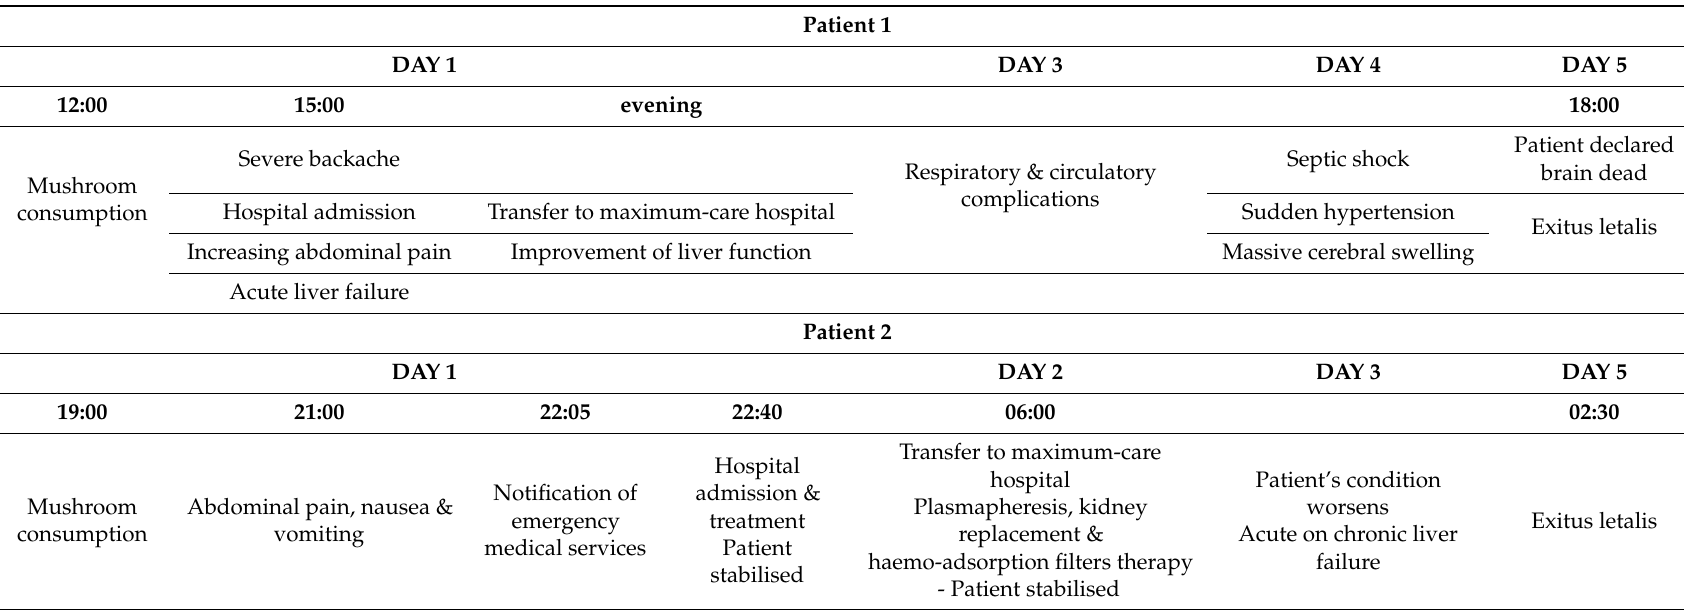
Table 1. Timeline of sequence of events between consumption and death of the two respective